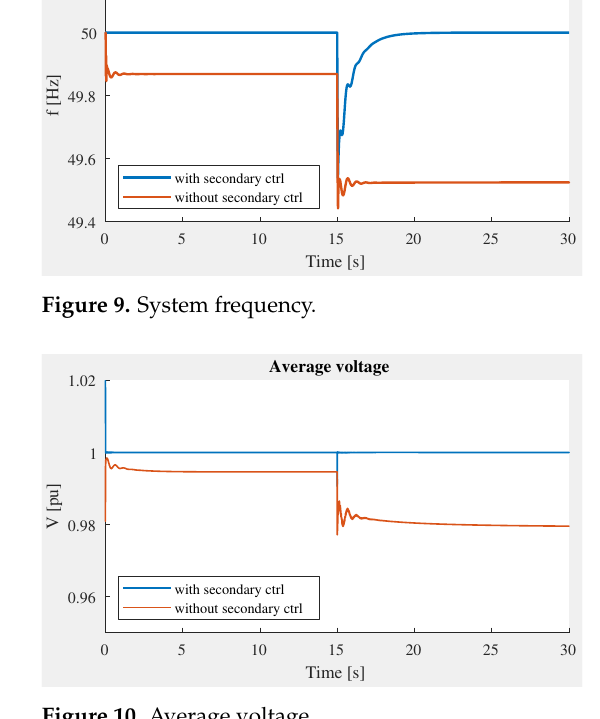
Figure 10. Average voltage.